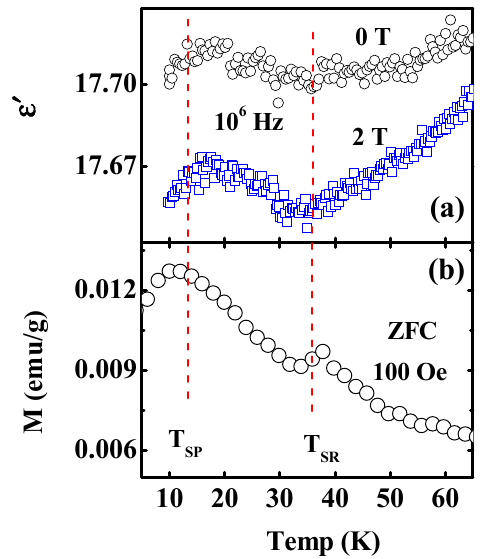
Figure 4. (Color online) ( a ) ε′ vs. temperature at different fields. ( b ) ZFC magnetization curve under 100 Oe.